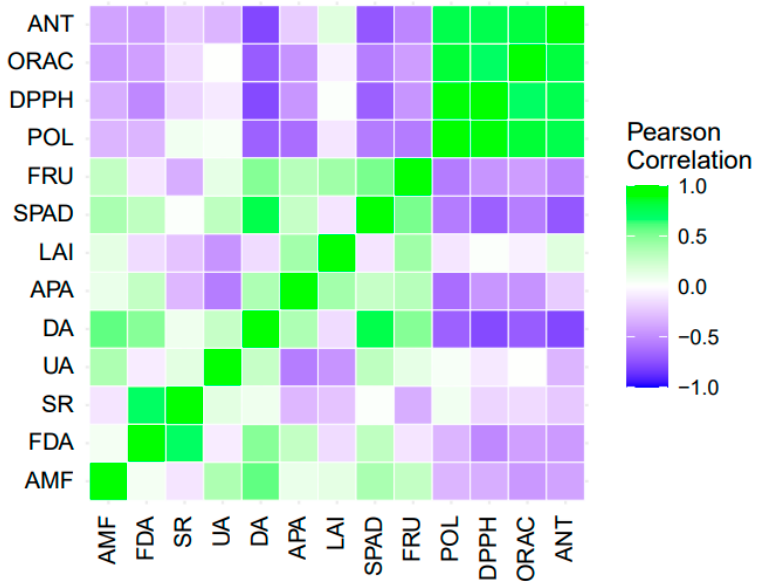
Figure 7. Correlation matrix for soil variables, plant physiological parameters, yield parameters and fruit bioactive compounds. AMF: Arbuscular mycorrhizal fungi; FDA: soil microbiological activity;